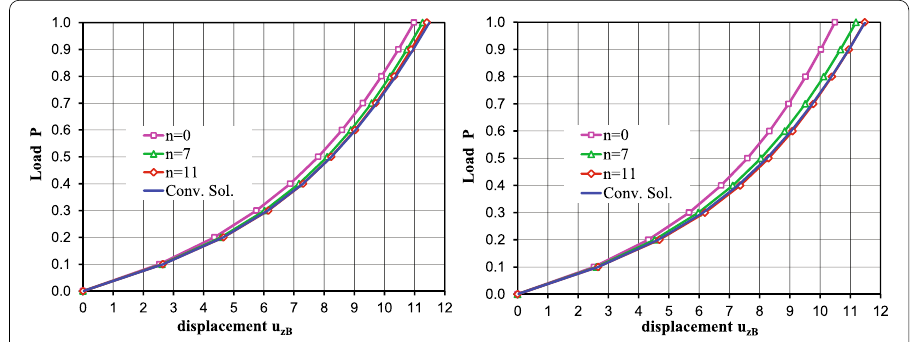
Fig. 34 Annular plate: p − u zB for a regular 4 × 20 mesh (left) and a distorted 4 × 20 mesh (right)